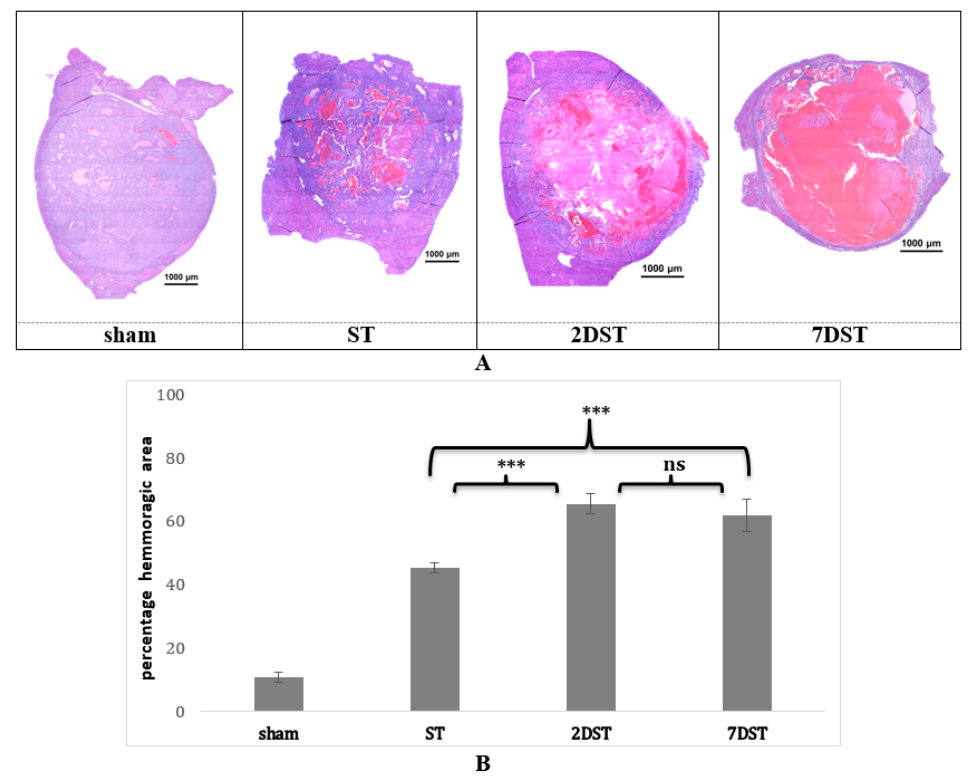
Figure 7. ( A ) Hematoxylin and eosin (H&E) staining of the HCC tumor samples. Small hemor- rhagic pools are seen in the tumors treated with a single (ST) compared to larger pools seen in subsequent (2DST, 7DST) therapies. More necrotic tissue is seen in 7DST tumors. No sensible change observed in sham cases. Area enclosed within the broken line represents the tumor. ( B ) Quantitative analysis of the hemorrhagic area of the HCC tumor samples. The bars represent the percentage of hemorrhagic area in the sham tumors, or treated with sham, single (ST) or subsequent in two days (2DST) or subsequent in seven days (7DST). The difference in the percentage of hemorrhagic area between sham vs. single Rx ( p < 0.001), sham vs. 2DST and 7DST ( p < 0.001), and ST vs. 2DST and 7DST ( p < 0.001) were statistically significant. *** represent significant difference between groups, while ns means non-significant difference.